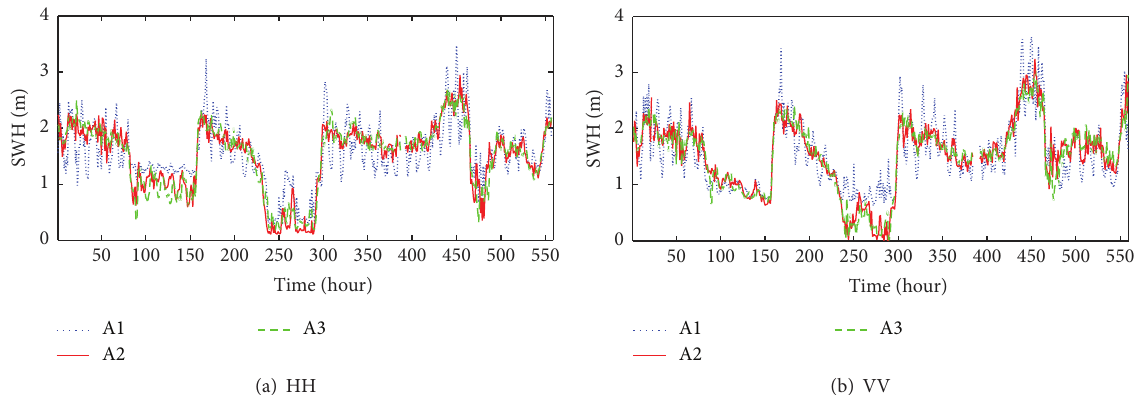
Figure 4: The SWH retrieved from the first principal component of X-band marine radars in Regions A1–A3. (a) HH polarization and (b) VV polarization.